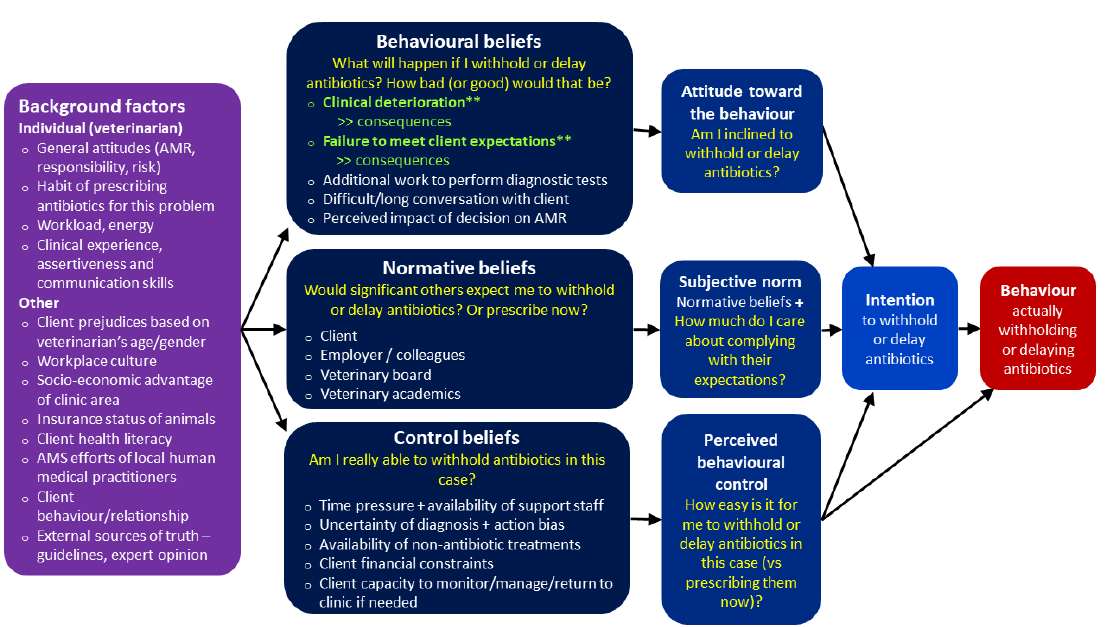
Figure 2. Summary of factors influencing veterinarians ’ decisions to withhold or delay antimicrobial treatment in the absence of a clear need, using an adaptation of the Theory of Planned Behaviour shown in Figure 1. ** Behavioural beliefs about clinical deterioration and failure to meet owner expectations were key themes and are further explored in Section 3.2.2.